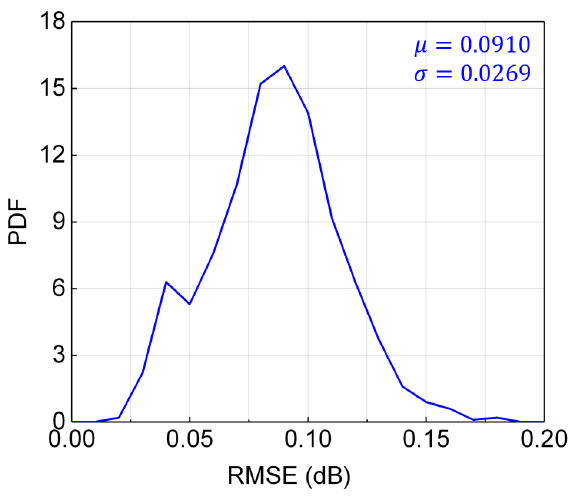
Figure 6. PDF of RMSE for arbitrary gain.